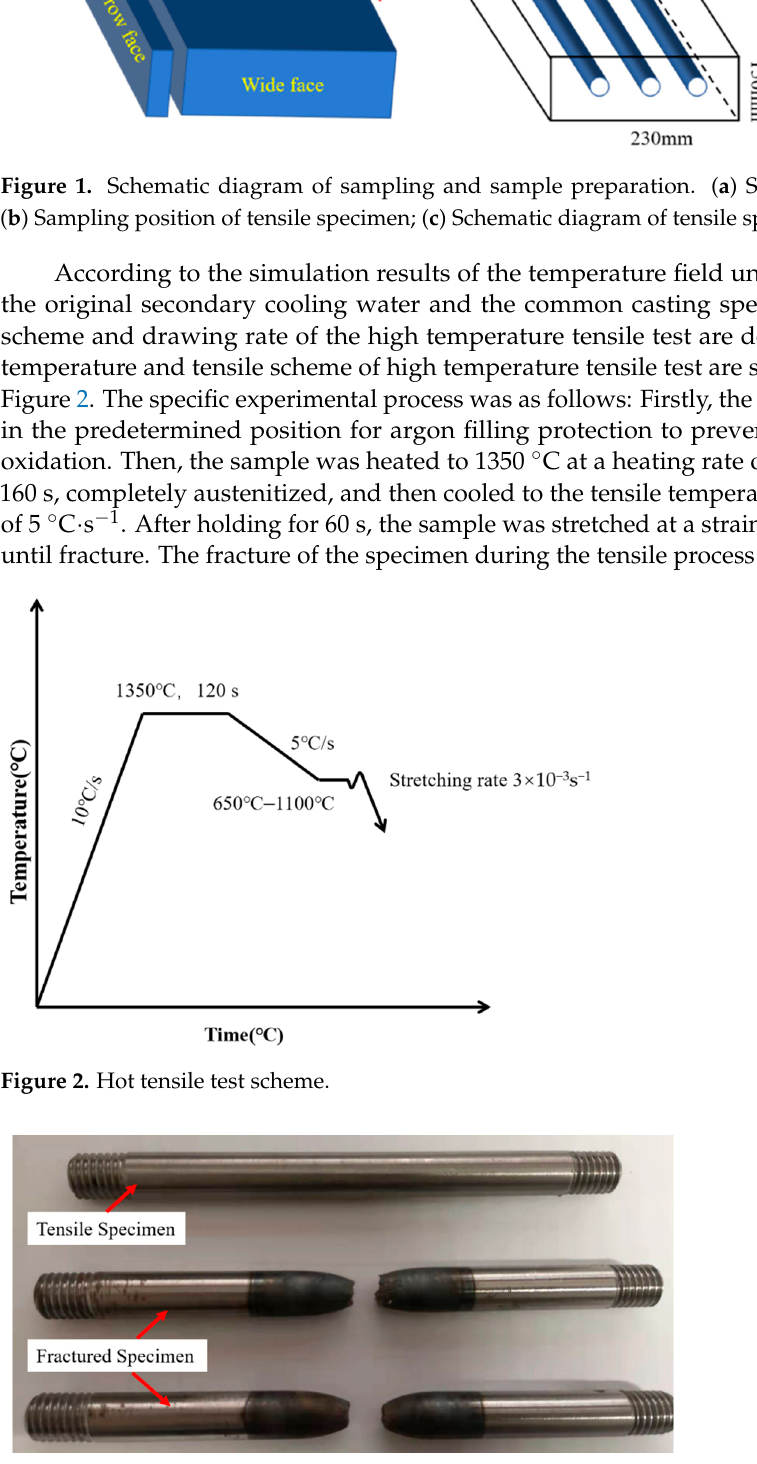
Figure 1. Schematic diagram of sampling and sample preparation. ( a ) Slab sampling location; ( b ) Sampling position of tensile specimen; ( c ) Schematic diagram of tensile specimen.